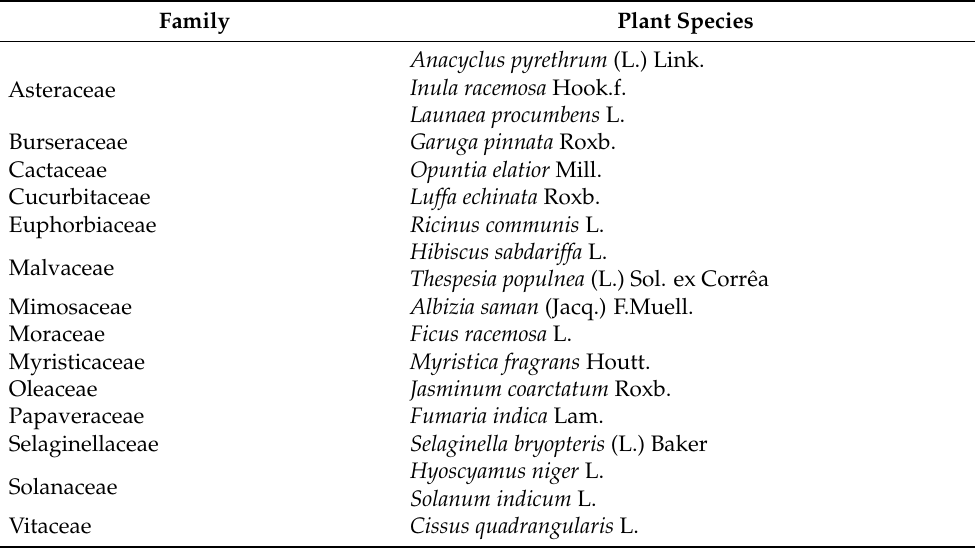
Table 6. Plant species with no modern literature evidence as snake envenomation